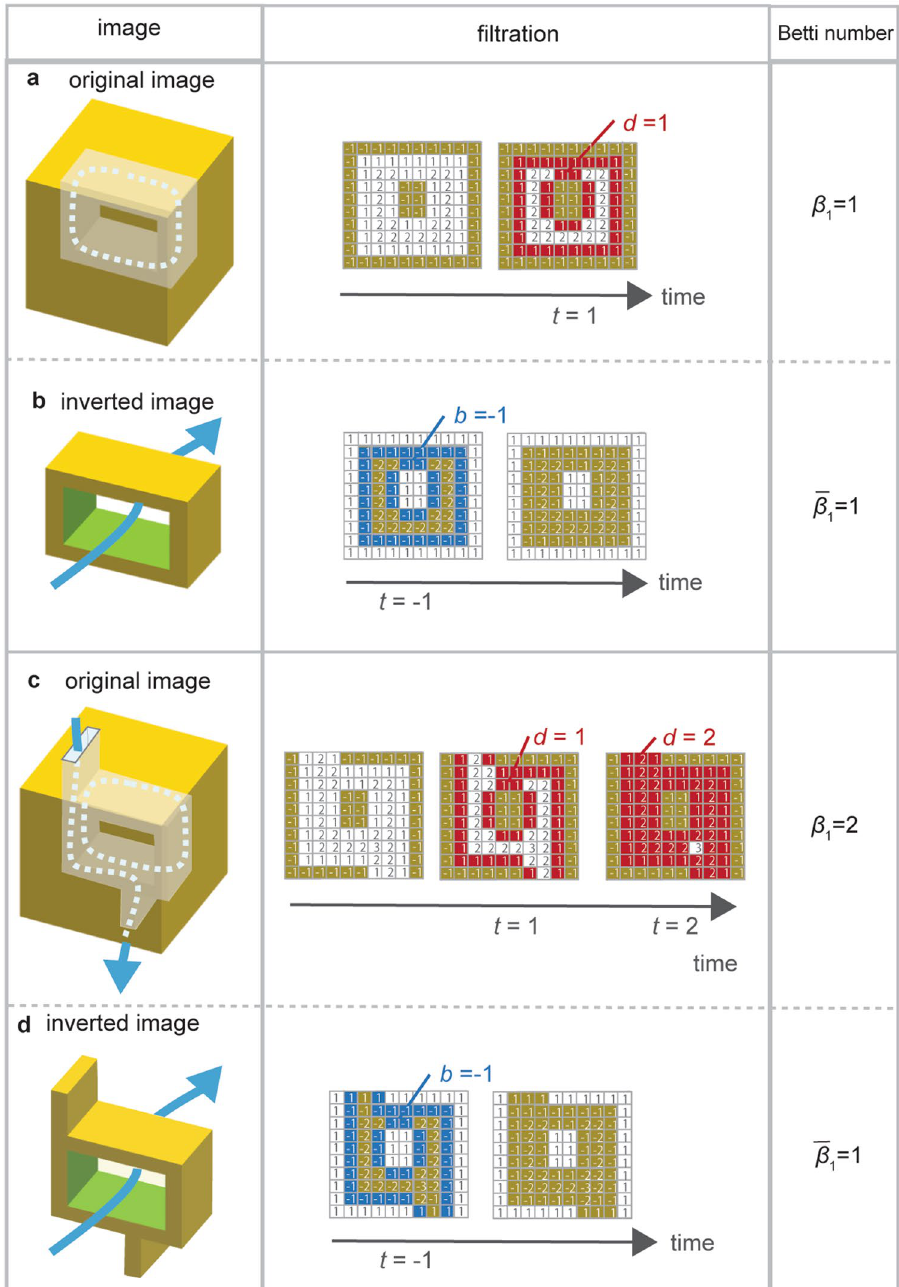
Figure 2. Detecting flow channels using inverted images ( a ) ring-shaped, internal void-structure that is not connected to the outside, and ( b ) its inverted image. ( c ) ring-shaped, internal void-structure with two channels that is connected to the outside and forms a flow channel. ( d ) Its inverted image. The left column shows 3D view of images. The center column describes processes of filtration. The right column lists Betti numbers b 1